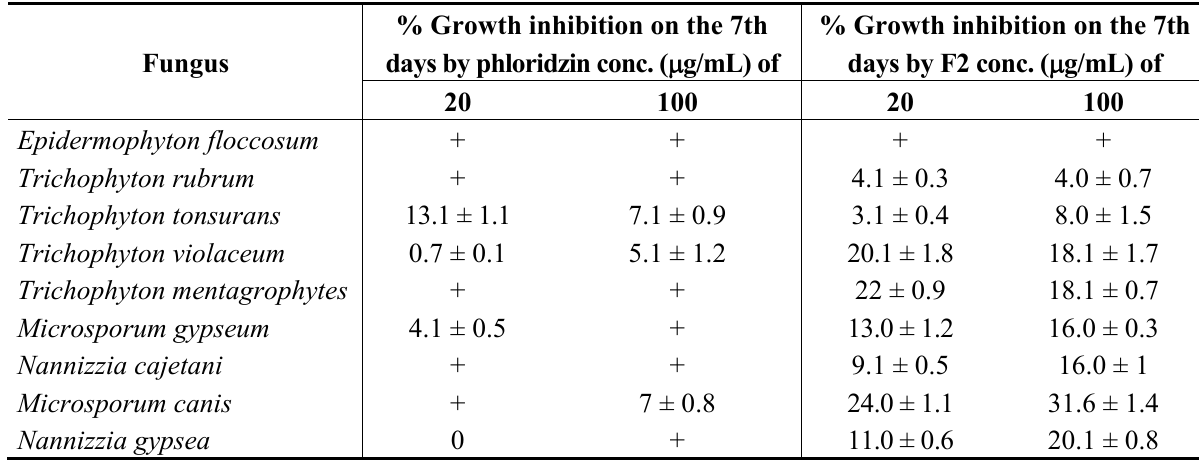
Table 2. Growth inhibition following treatment with the two pure standards phloridzin and its derivative F2